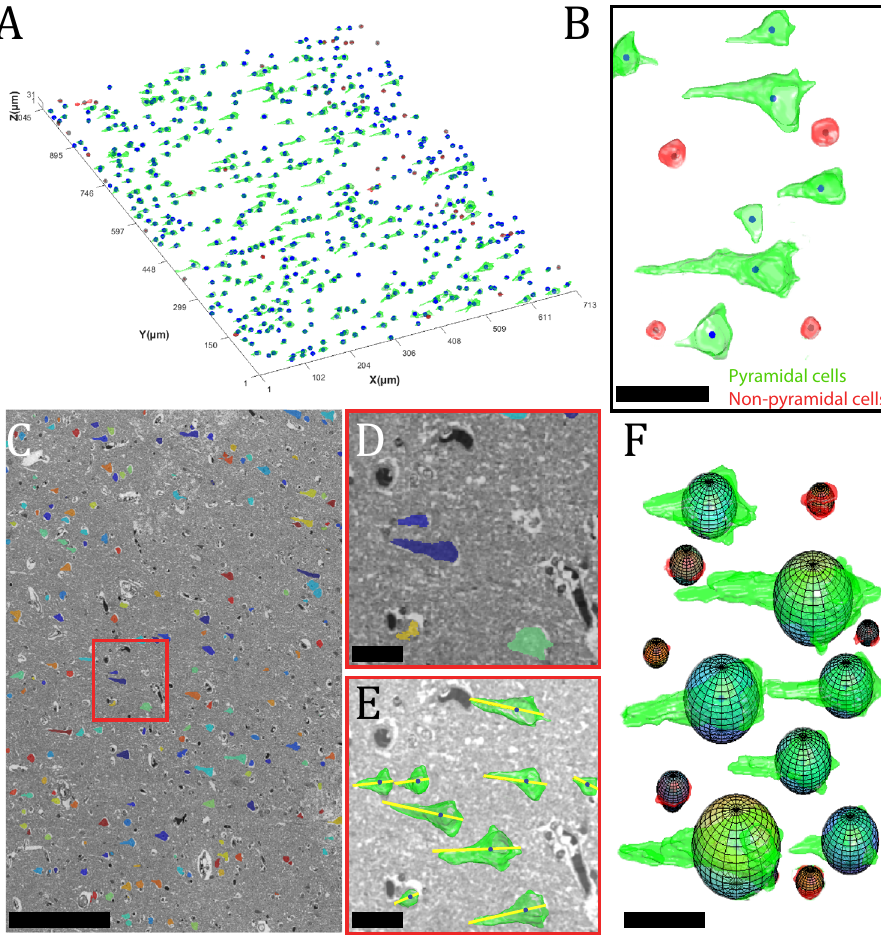
Fig. 5 Illustration of 3D-reconstruction of neurons and segmentation of pyramidal cells. A Visualization of the 3D-reconstruction of one layer neurons with a window height of 31 μ m. B Zoomed image of the segmented pyramidal and non-pyramidal cells. Scale bar = 20 μ m. C Overlay image of the binary segmented image with the gray-scale image of a section. Scale bar = 200 μ m. D , E Close-up view of the overlay picture and 3D-reconstruction of pyramidal cells, with yellow lines representing orientations. Scale bar = 15 μ m. F Measurement of diameter from the longest cell pro fi le Dia L was utilized to construct 3D spherical objects with their corresponding 3D-reconstructed cell. The graphic indicates that the difference in 3D volume space between the spherical approximation and the 3D-reconstructed item is similar. Scale bar = 20 μ m.